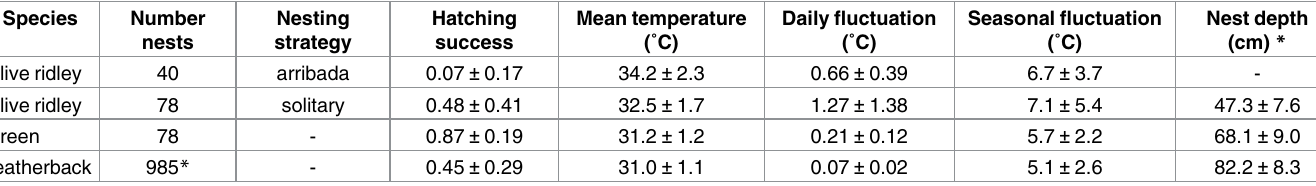
Mean ( ± SD) hatching success, mean ( ± SD) temperature (˚C), mean ( ± SD) daily fluctuation in temperature (˚C), mean ( ± SD) seasonal fluctuation in temperature (˚C) and mean ( ± SD) depth in olive ridley, green and leatherback turtle